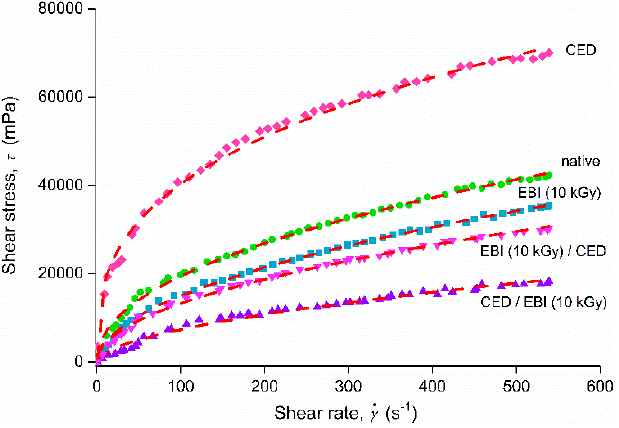
Figure 1. Flow curves of native and treated samples — fitted with the Ostwald de Waele